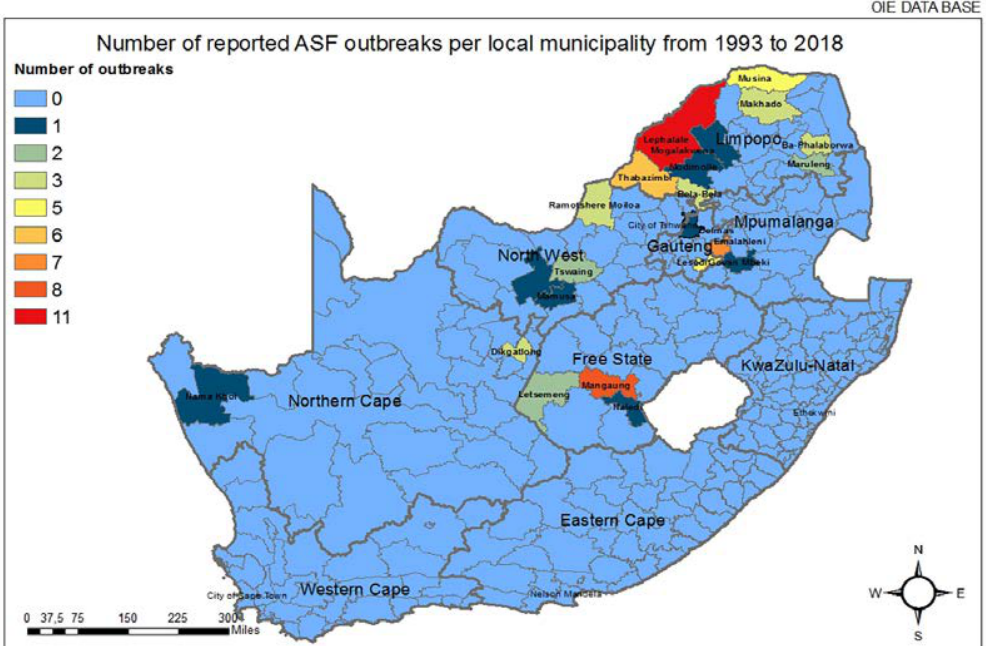
Figure 3: Number of ASF outbreaks per local municipality from 1993 to